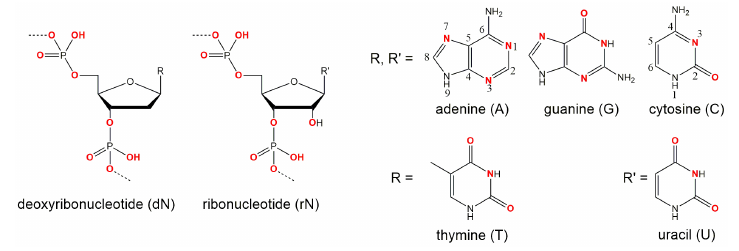
Figure 7. Potential metal interaction sites in DNA and RNA. The functional groups that are in principle capable of interacting with cations are highlighted in red. Besides the bridging and non-bridging oxygen atoms of the phosphate backbone of DNA and RNA and the 2’-oxygen atom in RNA sequences, the nitrogen atoms N1, N3, and N7 of purine bases, the N3 nitrogen atom of cytosine and the carbonyl oxygen atoms at position C2 and C4 in pyrimidine bases and C6 in guanosine can function as donor atoms for the coordination of metal ions at physiological pH values as well as deprotonated (N1) − of guanosine and (N3) − of thymidine and uracil. The exocyclic amino groups also have the potential to participate in metal ion coordination as hydrogen-bond donors within the first coordination sphere (reviewed in Reference [88]; and Reference